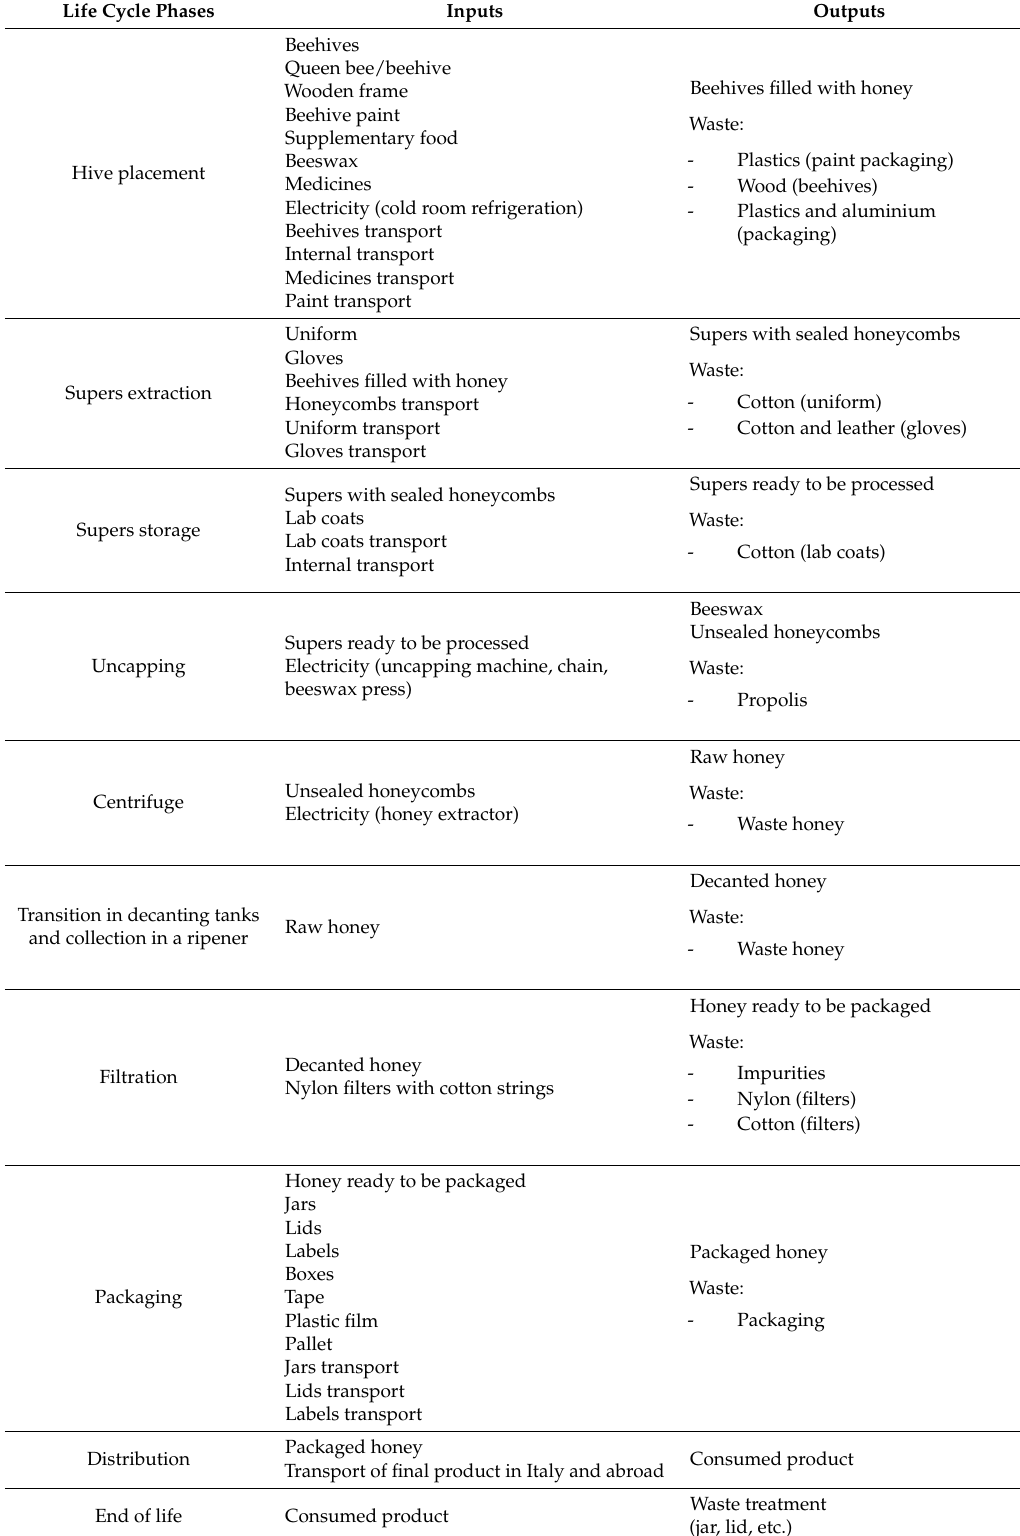
Table 1. LCI phase: Data collection inputs and outputs—intermediate flows (elaborated by the authors). Life Cycle